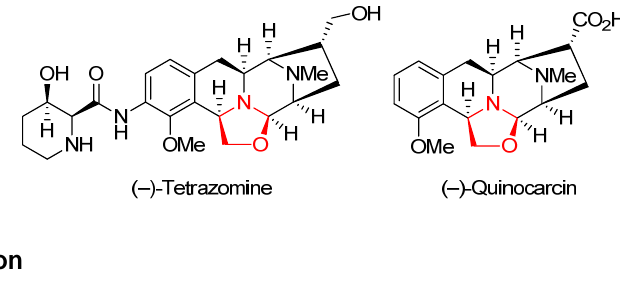
Figure 1. Oxazolidine-Containing Natural